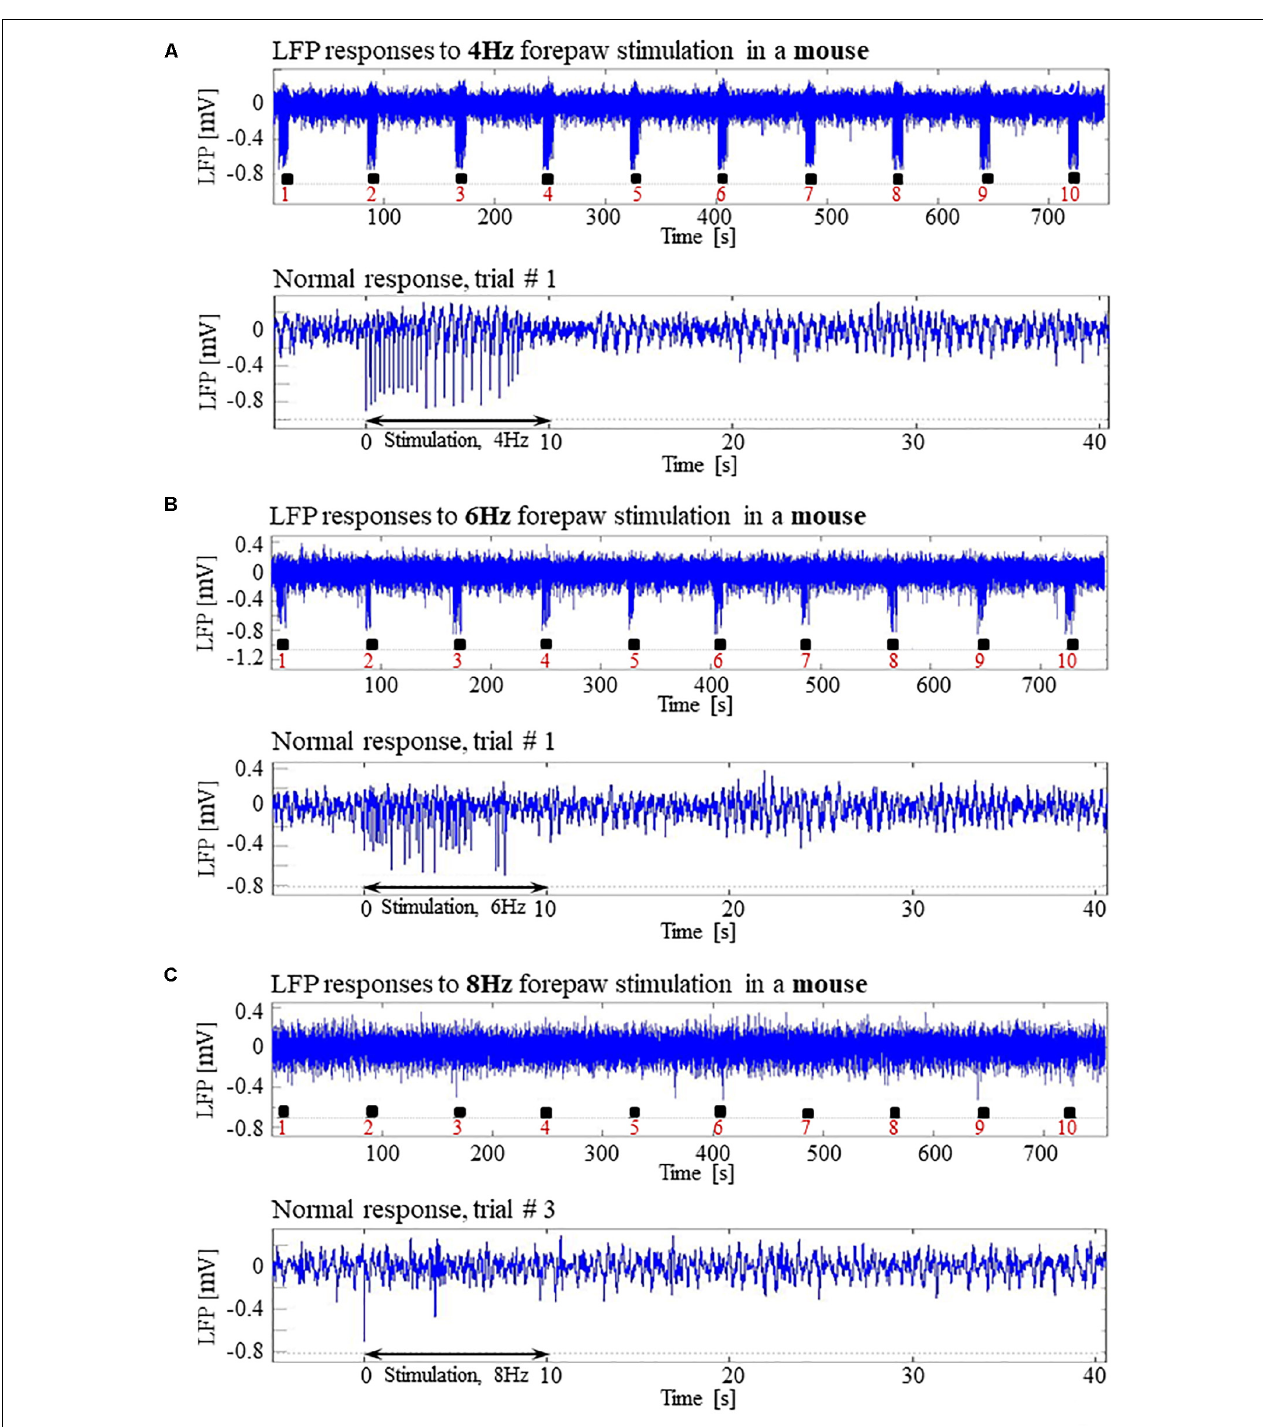
FIGURE 12 | Absence of seizures in the C57BL6 mouse strain. (A) Top: Normal LFP responses obtained from area S1FL, in response to 4 Hz forepaw stimulation. The panel shows ten trials, each with 10 s-long stimulation. The stimulation blocks are marked by black rectangles. Bottom: A magnification of the normal evoked response from the first trial. (B) Top: Normal LFP responses to 6 Hz forepaw stimulation. Bottom: A magnification of the normal evoked response from the first trial. (C) Top: A typical activity pattern of evoked responses to 8 Hz forepaw stimulation. Bottom: A magnification of the normal evoked response from the third trial.